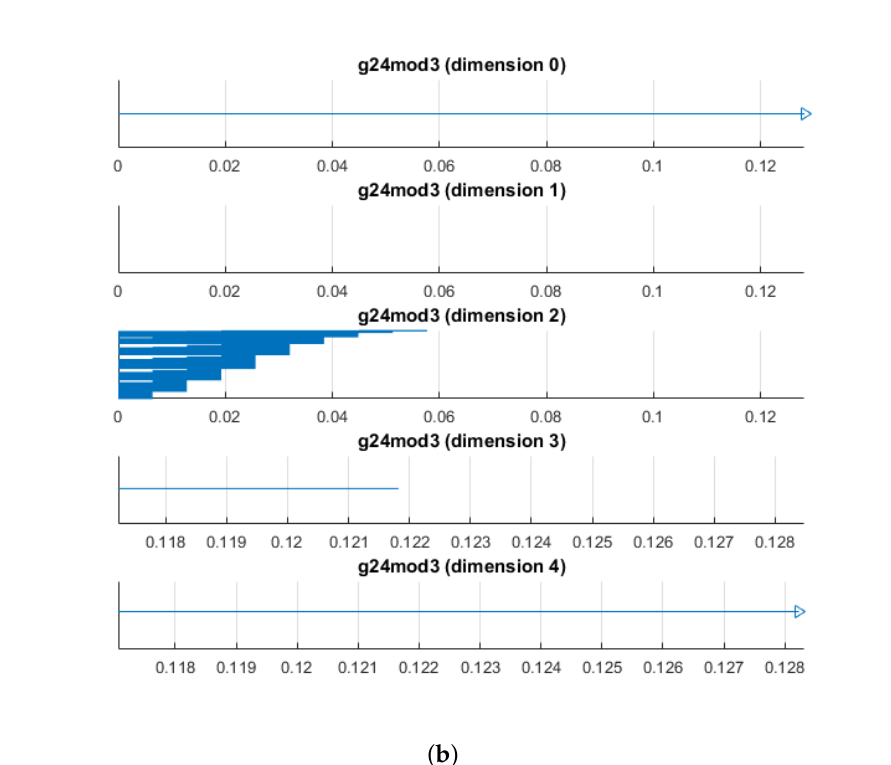
Figure 13. Barcodes for a witness complex on 100 points in a 5000-point sample on G 2 ( R 4 ) ( a ) Z /2 coefficients and ( b ) Z /3